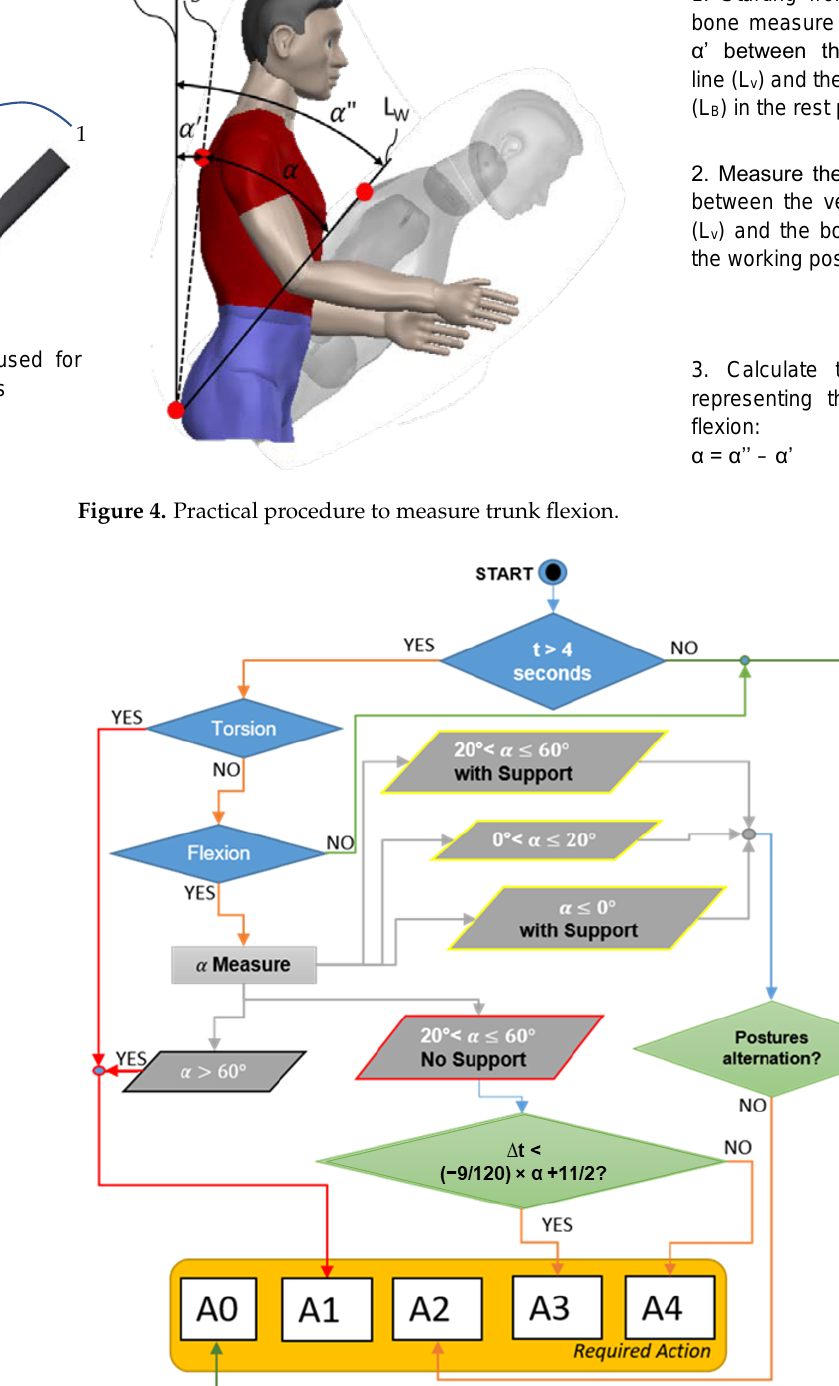
Figure 5. Overview of the procedure to evaluate the posture of the trunk, where: A0 stands for “ac- ceptable”; A1 means “not recommended—workstation redesign”; A2 stands for “not recom- mended—workflow redesign”; A3 means “not recommended—need for recovery time”; A4 means “not recommended—reduction of holding time”.